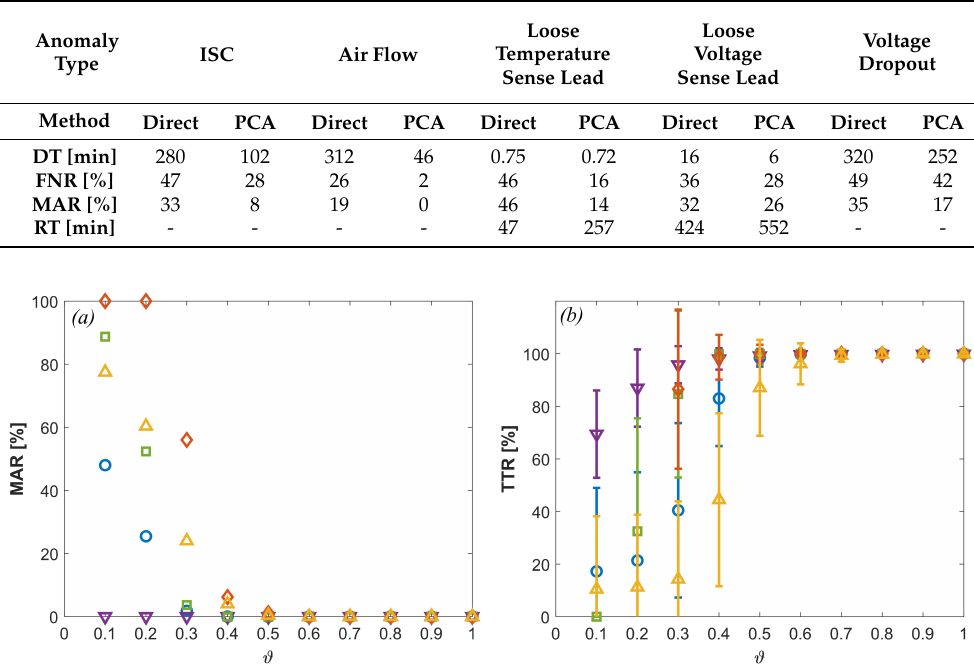
Figure 11. PCA method: ( a ) missed anomaly rate versus anomaly magnitude; ( b ) true tracing rate versus anomaly magnitude: (cid:13) ISC, (cid:53) air flow, (cid:3) loose temperature sense lead, ♦ loose voltage sense lead, and (cid:52) voltage